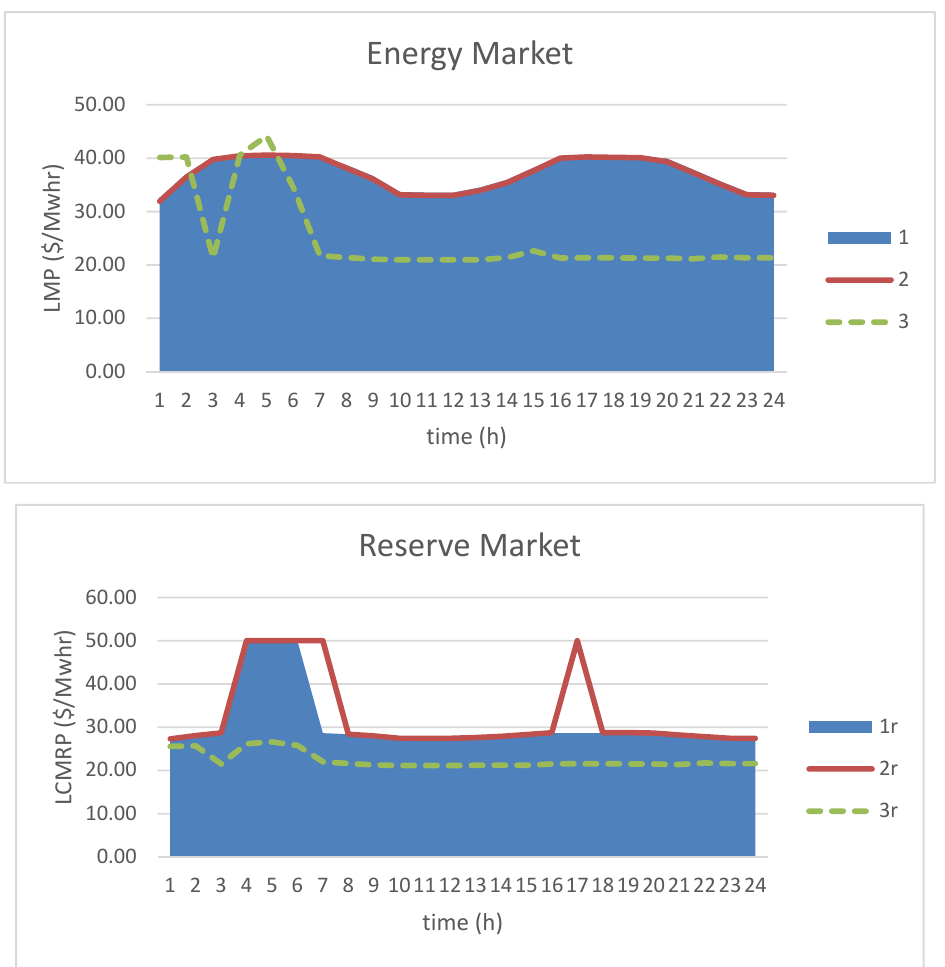
Figure 3. Day-ahead maximum Locational Marginal Pricing (LMP) and Locational Contingency Figure 3. day-ahead maximum Locational Marginal Pricing (LMP) and Locational Contingency Marginal Reserve Pricing Marginal Reserve Pricing (LCMRP).